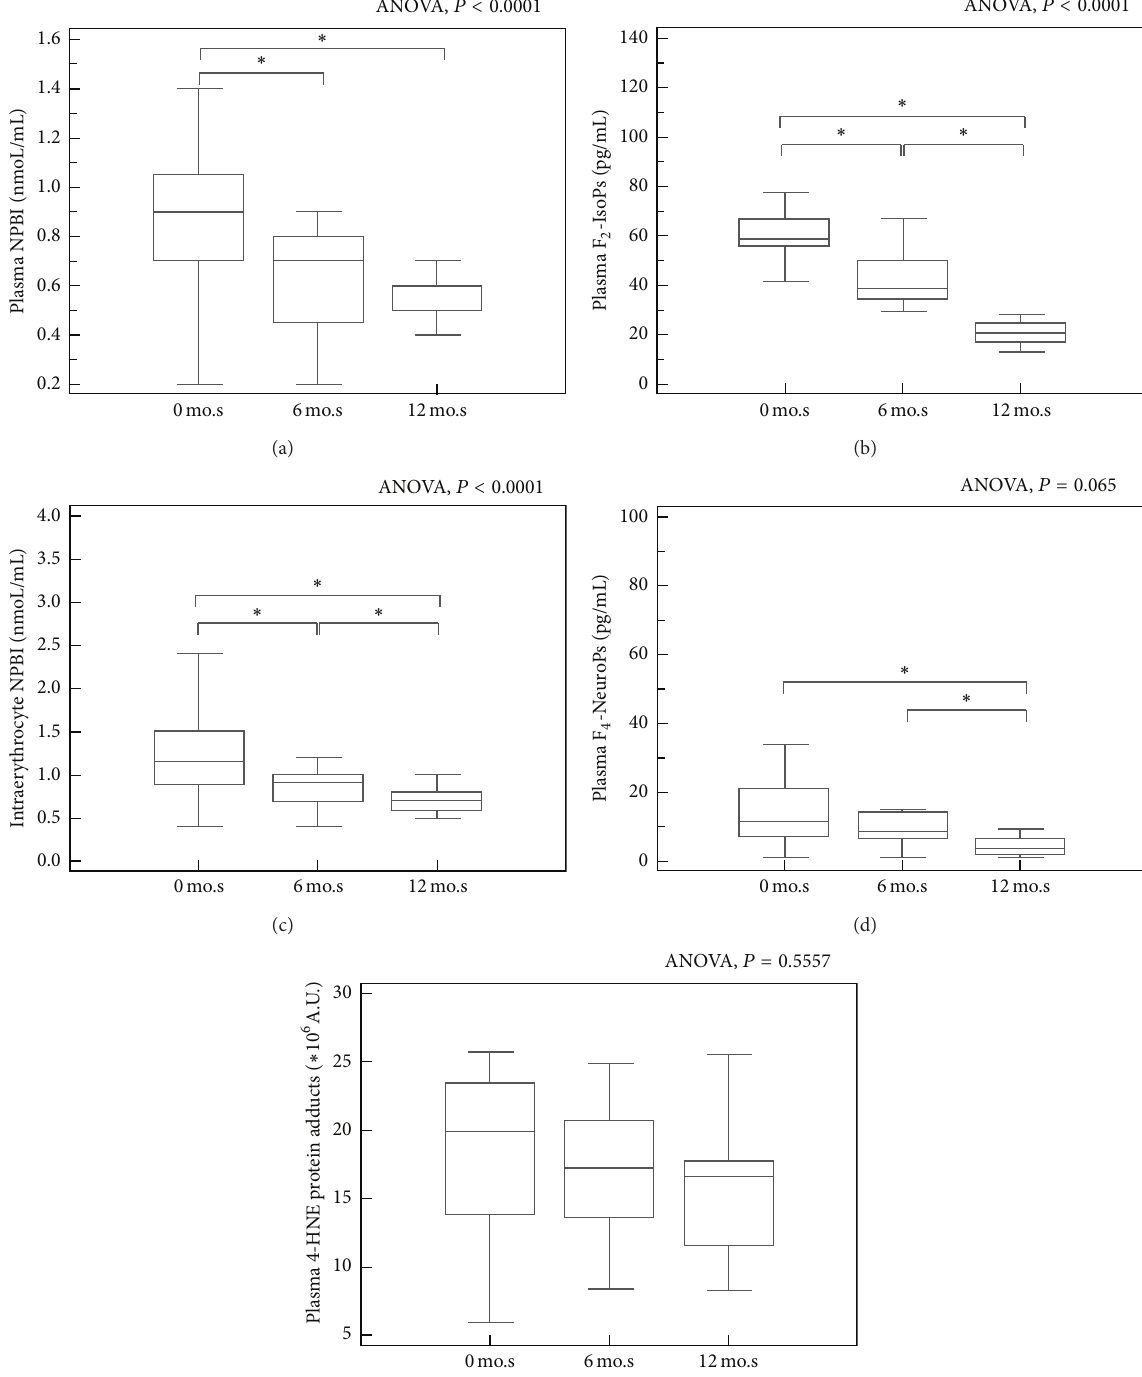
Figure 2: Oxidative stress markers levels (NPBI, plasma F 2 -IsoPs, and F 4 -NeuroPs) are significantly reduced in the 𝜔 -3 PUFAs supplemented Rett population, as compared to basal values (Panels (a)–(d)). Conversely, no significant changes were observed for 4-HNE PAs values (Panel (e)). ∗ denotes 𝑃 value < 0.05. NPBI: non protein-bound iron; F 2 -IsoPs: plasma free F 2 -isoprostanes; F 4 -NeuroPs: plasma free F 4 - neuroprostanes; 4-HNE protein adducts: 4-hydroxynonenal protein adducts; mo.s: